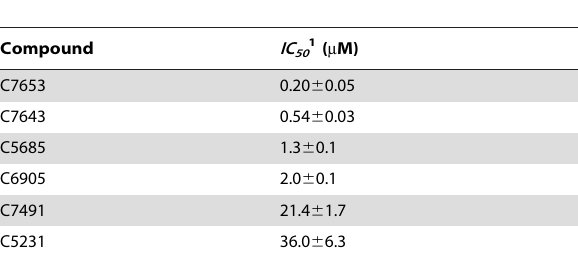
Table 2. IC 50 values of the hits for which crystal structures were successfully determined.